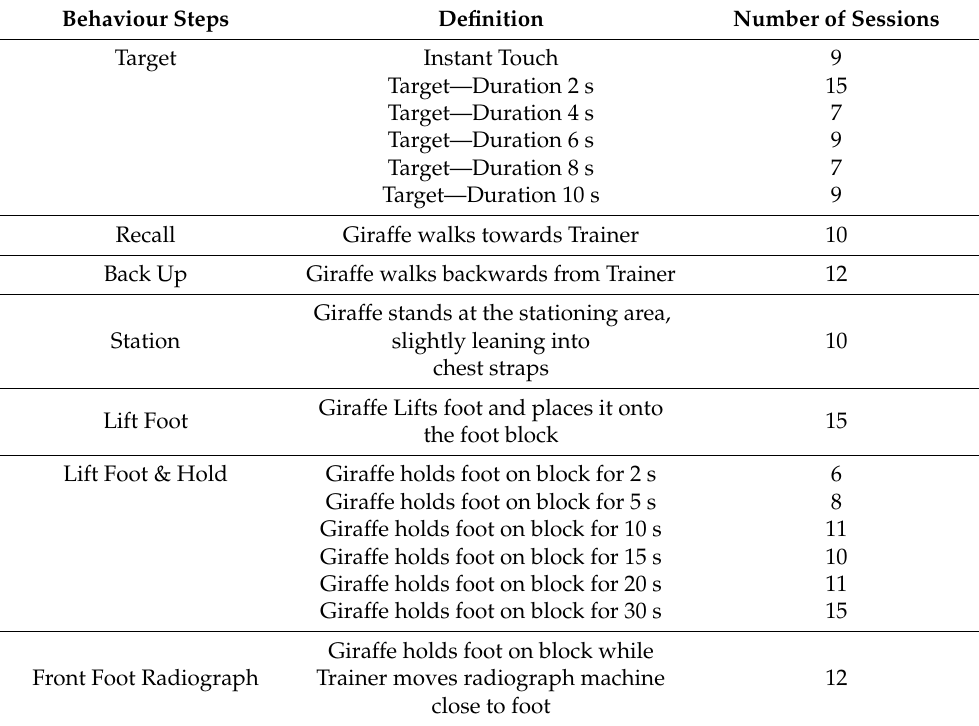
Table 1. Behaviour steps, descriptions and sessions as described in the Shaping Plan.